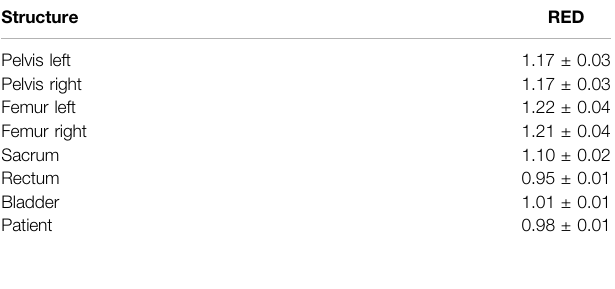
TABLE 5 | Mean ± standard deviation of REDs, derived from the independent database of 50 patients for the structures the ED assignment was performed on for the PBCT